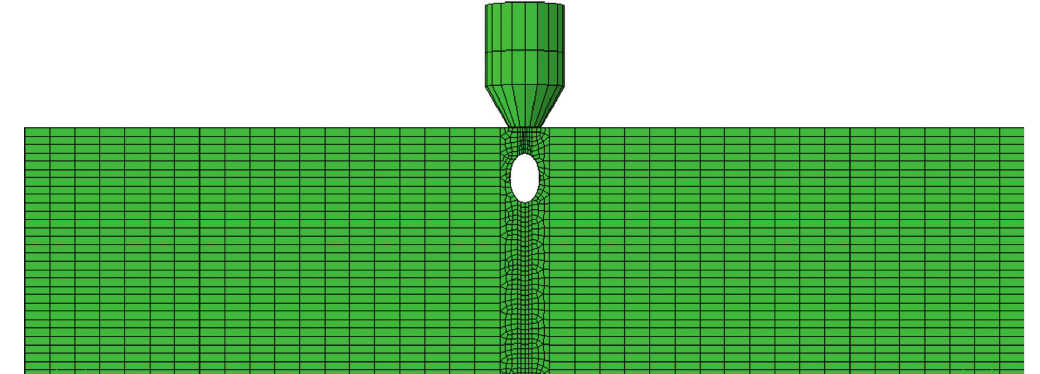
Figure 9: Model mesh